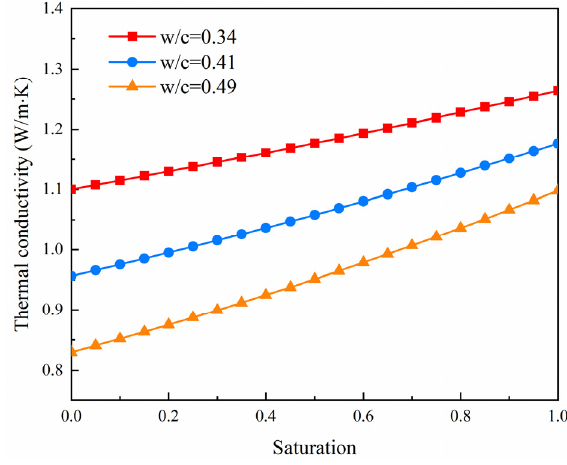
Figure 8. Evolution of the thermal conductivity against curing temperature at dry state.